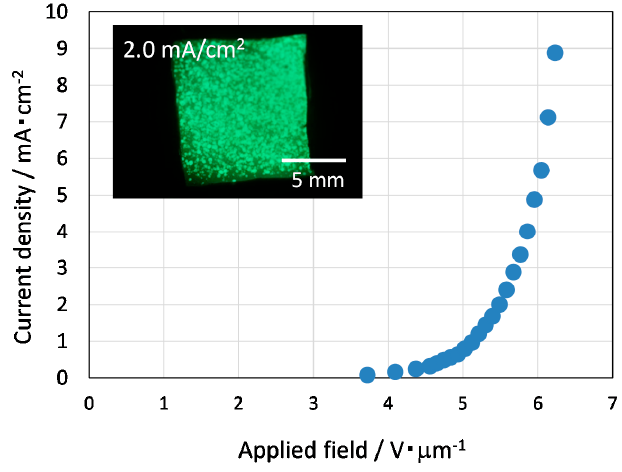
Figure 4. Current density–electric-field characteristics of metallic SWCNTs. The inset shows the planar lighting.